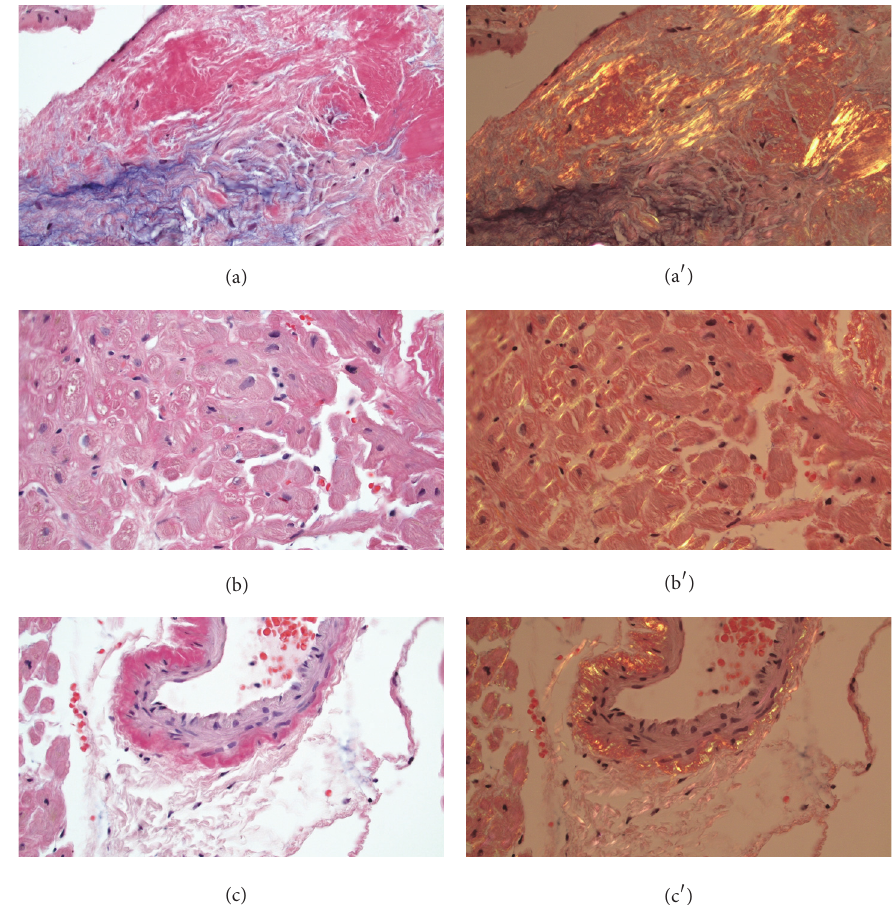
Figure 2: Endomyocardial biopsies. (a) Endocardial infiltration, congo stain; (a 󸀠 ) endocardial infiltration, congo stain and polarization; (b) interstitial amyloid deposits, congo stain; (b 󸀠 ) interstitial amyloid deposits, congo stain and polarization; (c) intramural coronary vessel, congo stain; (c 󸀠 ) intramural coronary vessel, congo stain and